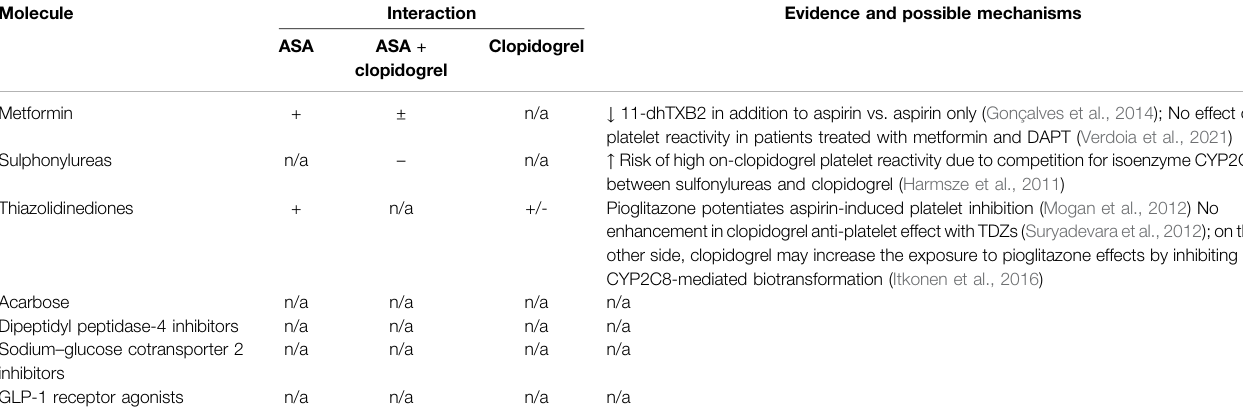
TABLE 2 | Drug – drug interactions between anti-diabetic and anti-platelet agents. Molecule Interaction Evidence and possible